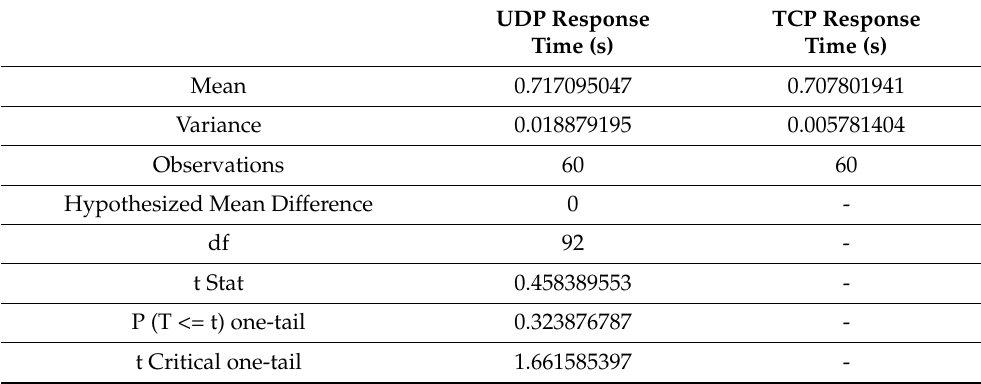
Table 4. Results, Experiment